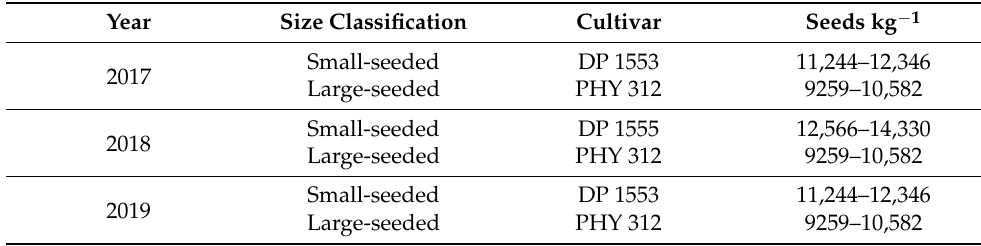
Table 4. Cotton cultivars (and their seed size) planted in the studies conducted in 2017, 2018 and